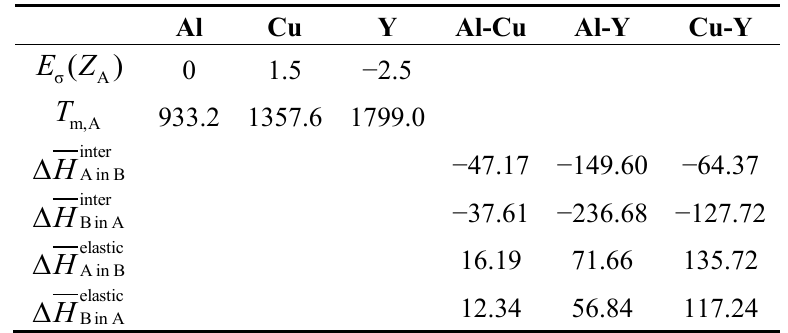
Table 1. The parameters used in the thermodynamic calculations for the Al-Cu-Y system. expressed in K.